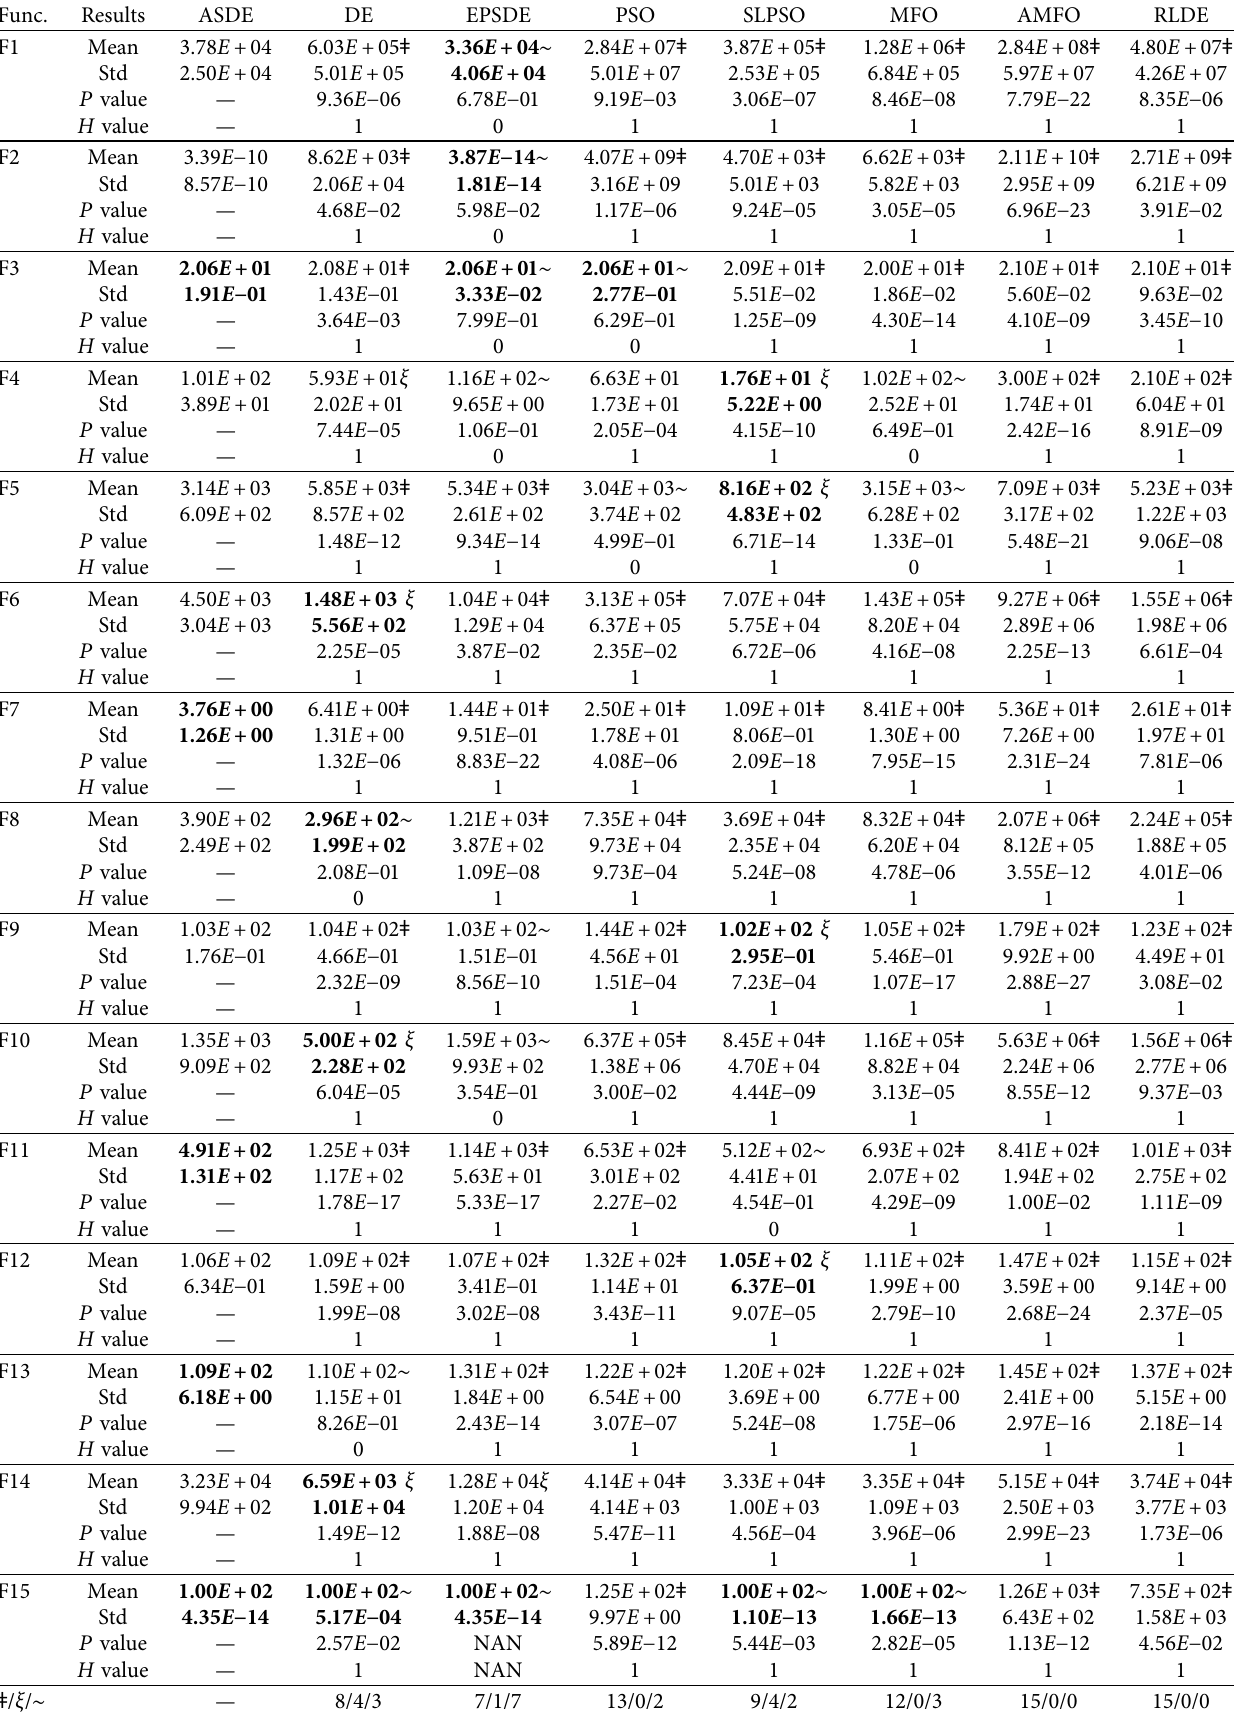
Table 1: Results of solution accuracy gained by eight algorithms on 15 benchmark functions of CEC2015.